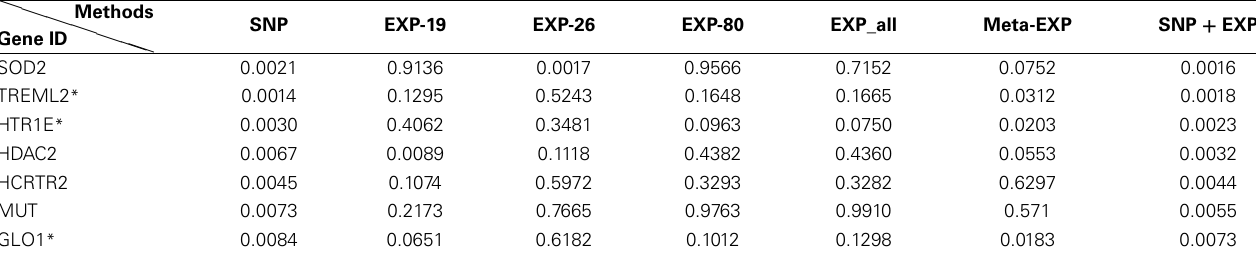
Table 3 | The top 7 identified genes and their p -values by sparse multitask-sglasso method in bone mineral density studies. (cid:2) (cid:2) (cid:2) (cid:2) (cid:2) (cid:2)(cid:2) Gene ID